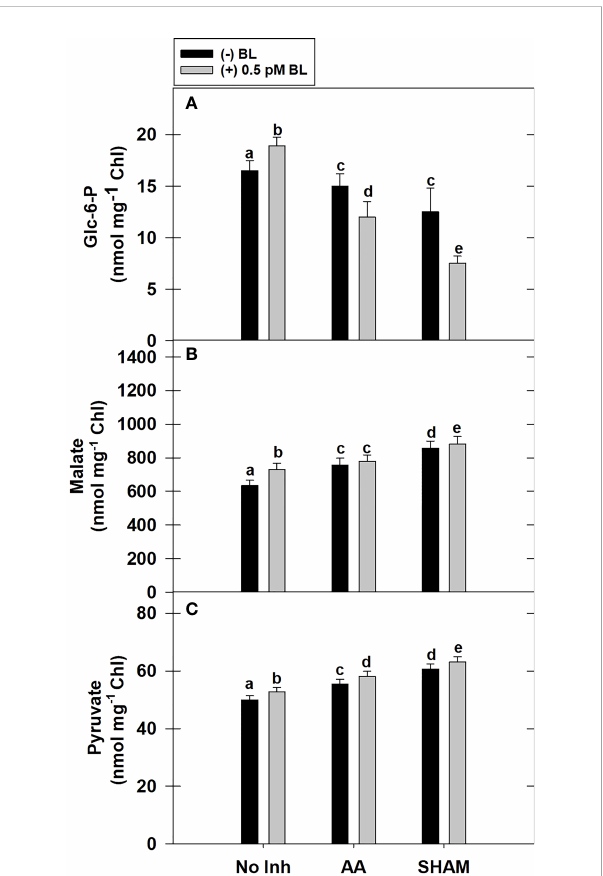
FIGURE 5 Effect of BL on the total cellular level of Glc-6-P (A) , Malate (B) and Pyruvate (C) under the disruption of COX or AOX pathway in MCP of A . thaliana . The MCP in the reaction medium was pre-incubated with or without 0.5 pM BL in the presence or absence of 100nM AA (COX pathway Inhibitor) or 0.5 mM SHAM (AOX pathway inhibitor) for 10 min at a light intensity of 1000 m mol m -2 s -1 at 25°C. After treatment, MCP was immediately quenched by HClO 4 and stored in liquid N 2 for analysis. Further, the section “ materials and methods ” mentions more detailed information on the procedure. No Inhibitor (No Inh) depicts a sample without mETC inhibitors. A statistically signi fi cant difference is represented by different lowercase alphabetical letters. (P ≤ 0.05) and values represent the average (± SE) of three